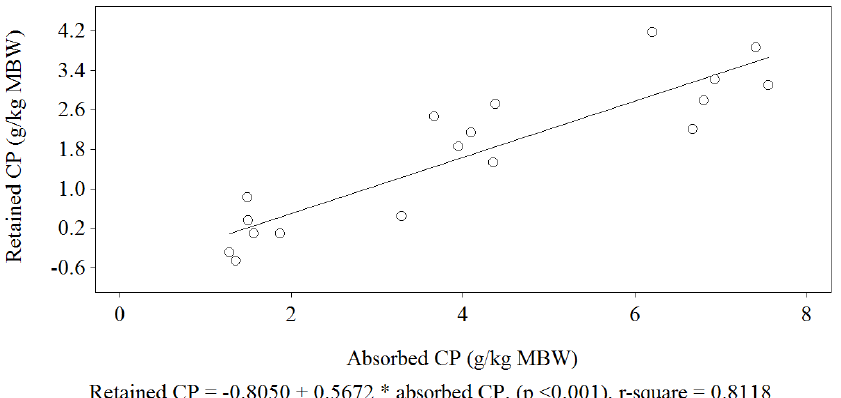
Figure 2. Regression equation of daily retained crude protein (CP) according to daily absorbed CP by female spotted deer (MBW = BW 0.75 ) (MBW, metabolic body weight; BW, Body weight). Table 4. Blood urea nitrogen of female spotted deer fed diets with